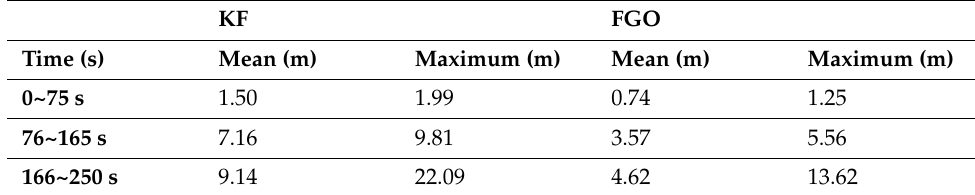
Table 4. Longitude-position errors analysis and companions.